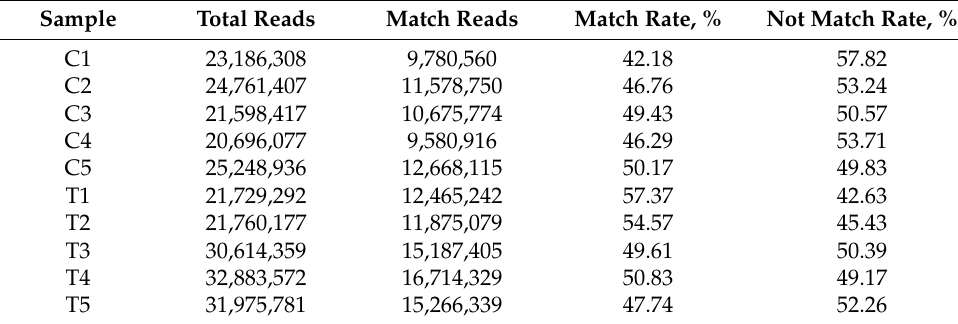
Table 1. Basic and mapping data of small RNA sequencing.